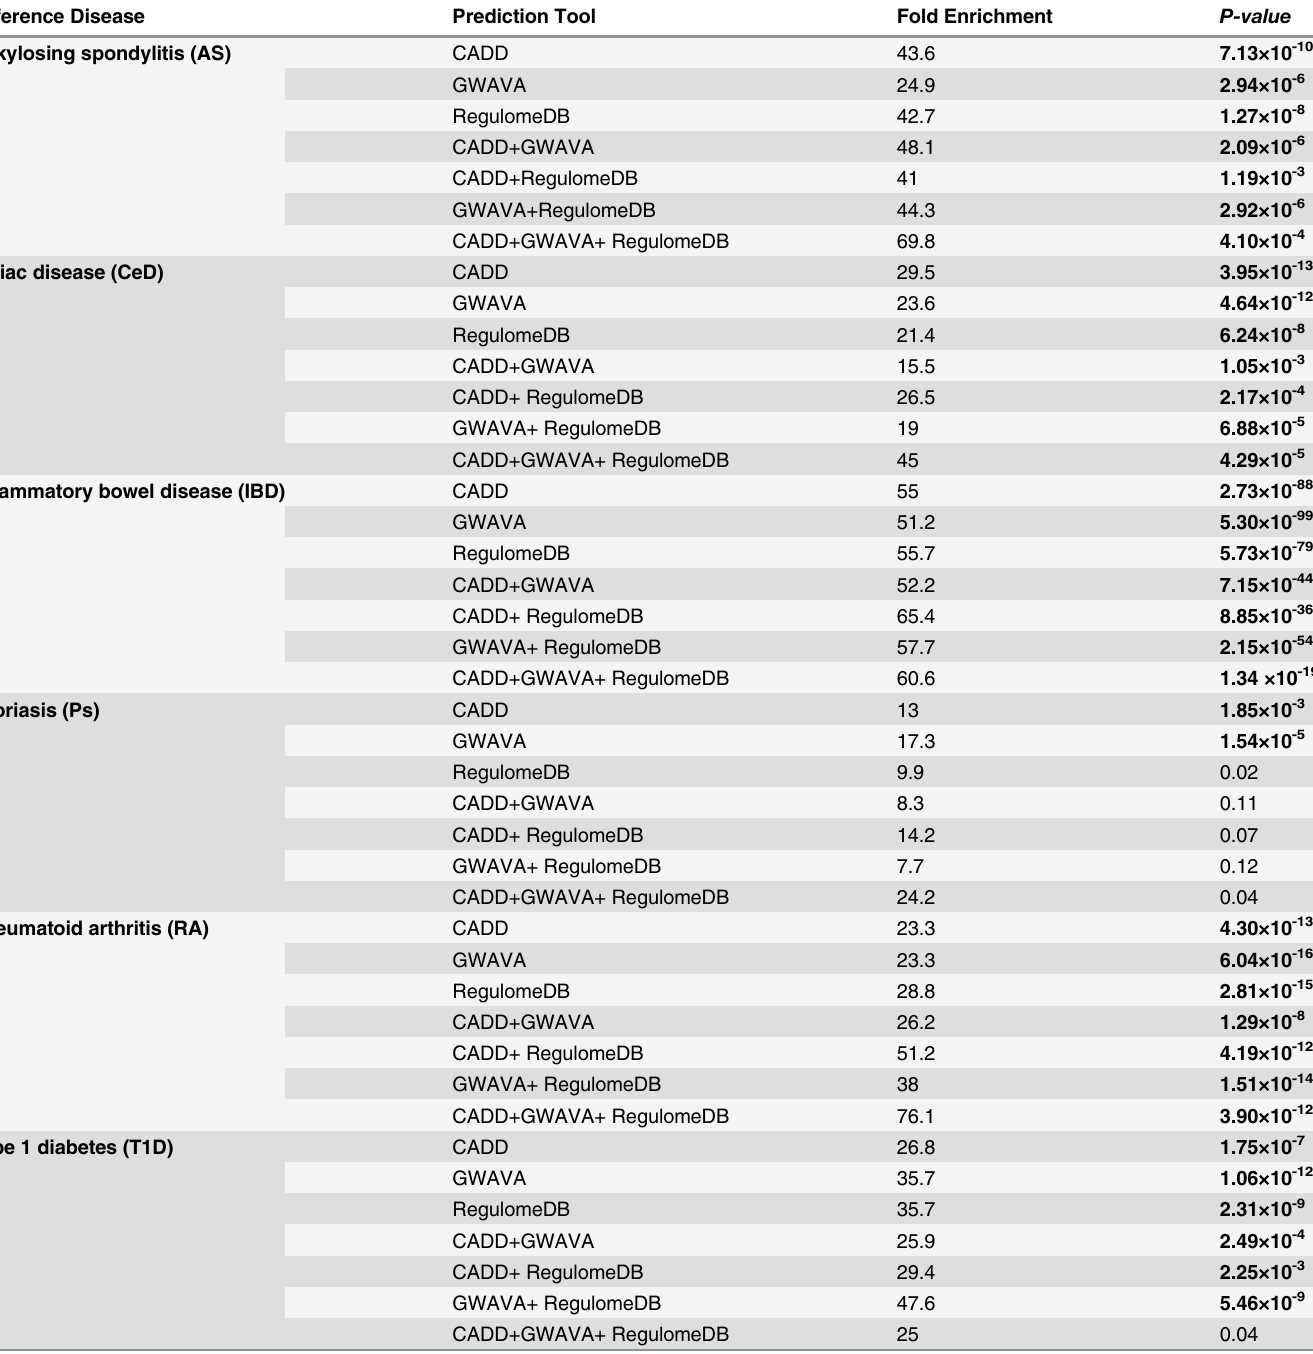
Table 3. Summary of the enrichment scores for genes in six immune-mediated diseases (IMDs) using a combination of CADD, GWAVA and RegulomeDB prediction